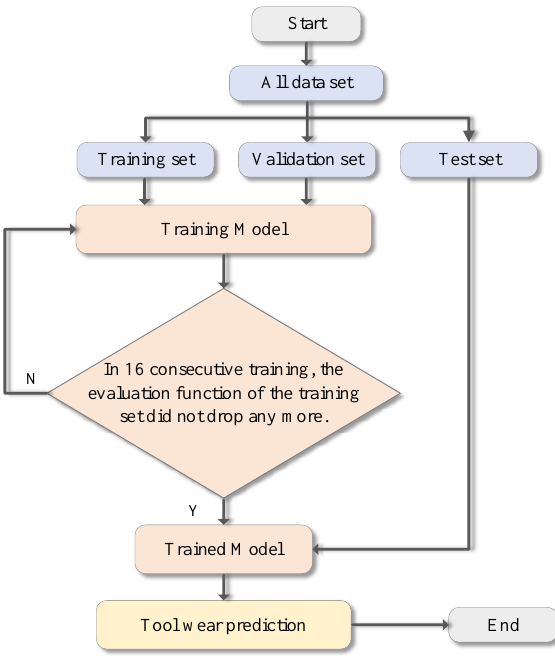
Figure 4. The flowchart of the proposed method.